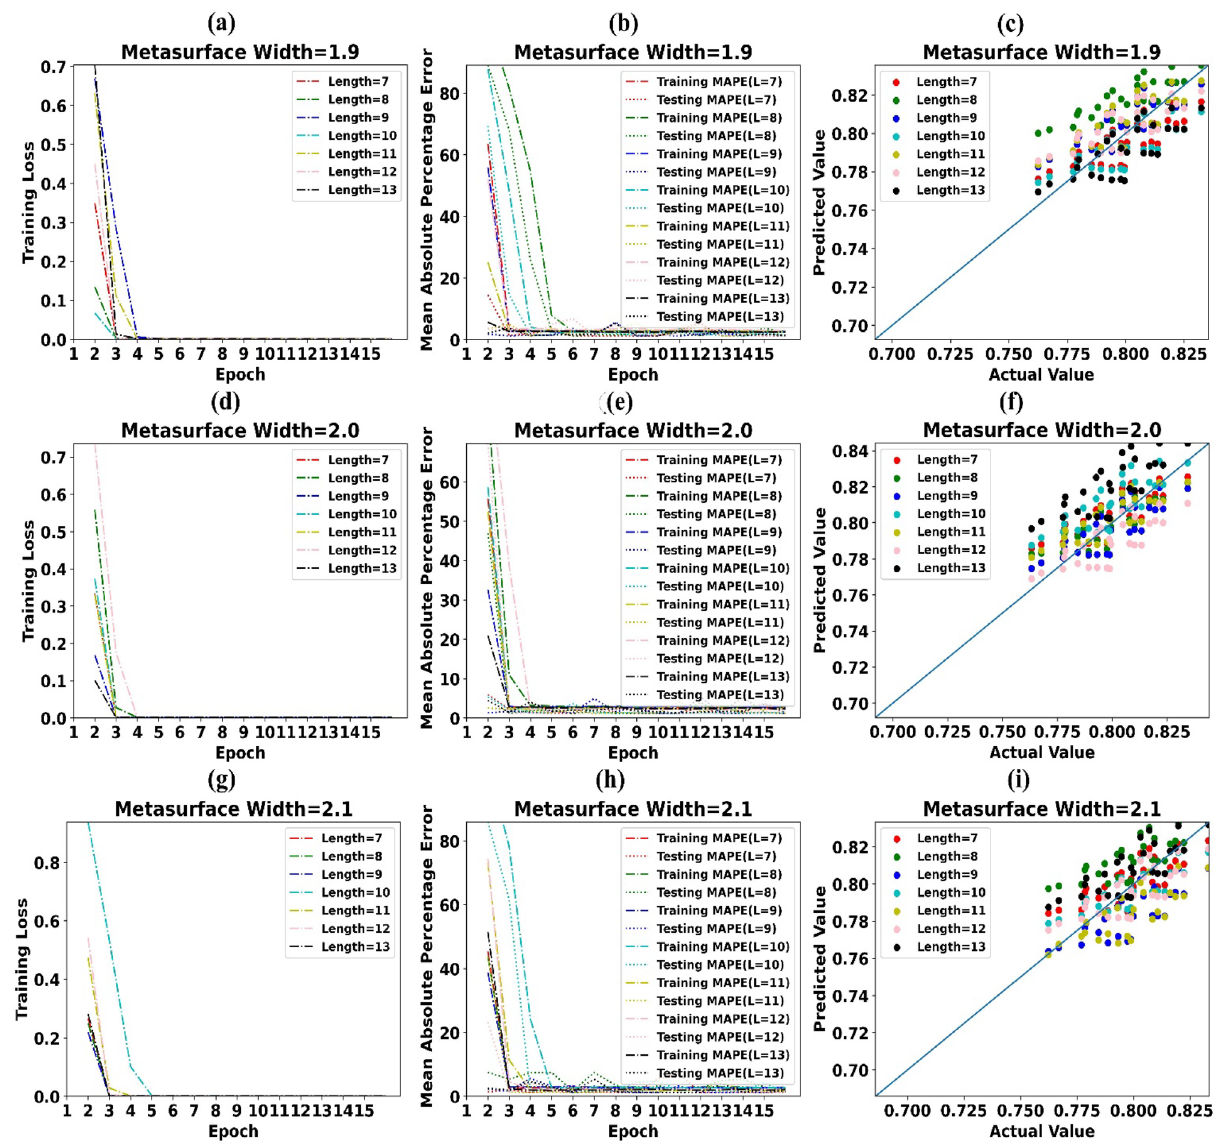
Figure 7. ( a ) Training Loss of LSTM model for Metasurface Width 1.9 µm ( b ) MAPE of LSTM model for Metasurface Width 1.9 µm ( c ) Predicted values of absorption by LSTM vs simulated values of absorption for Metasurface Width 1.9 µm ( d ) Training Loss of LSTM model for Metasurface Width 2.0 µm ( e ) MAPE of LSTM model for Metasurface Width 2.0 µm ( f ) Predicted values of absorption by LSTM vs simulated values of absorption for Metasurface Width 2.0 µm ( g ) Training Loss of LSTM model for Metasurface Width 2.1 µm ( h ) MAPE of LSTM model for Metasurface Width 2.1 µm ( i ) Predicted values of absorption by LSTM vs simulated values of absorption for Metasurface Width 2.1